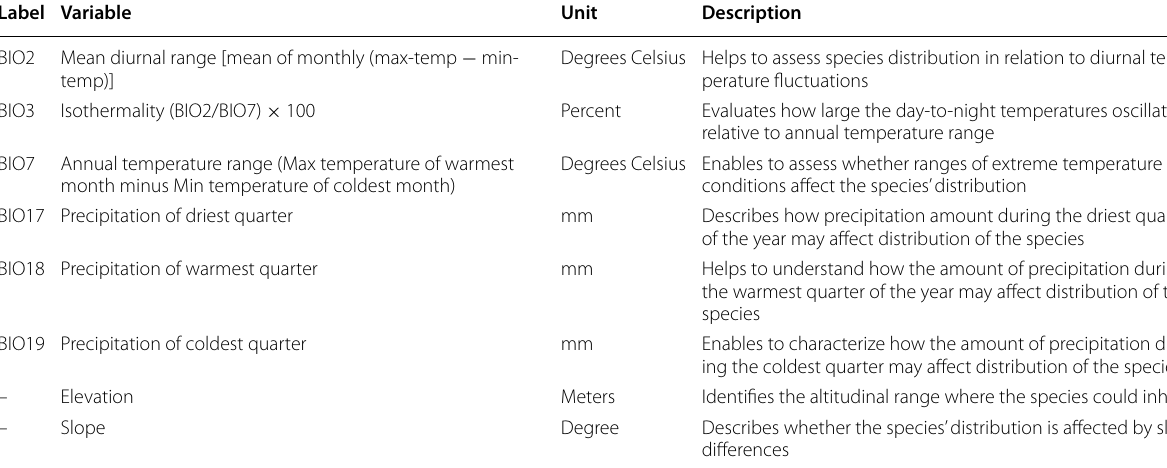
Table 2 Environmental variables used as predictors (selected after multicollinearity and jackknife importance test)